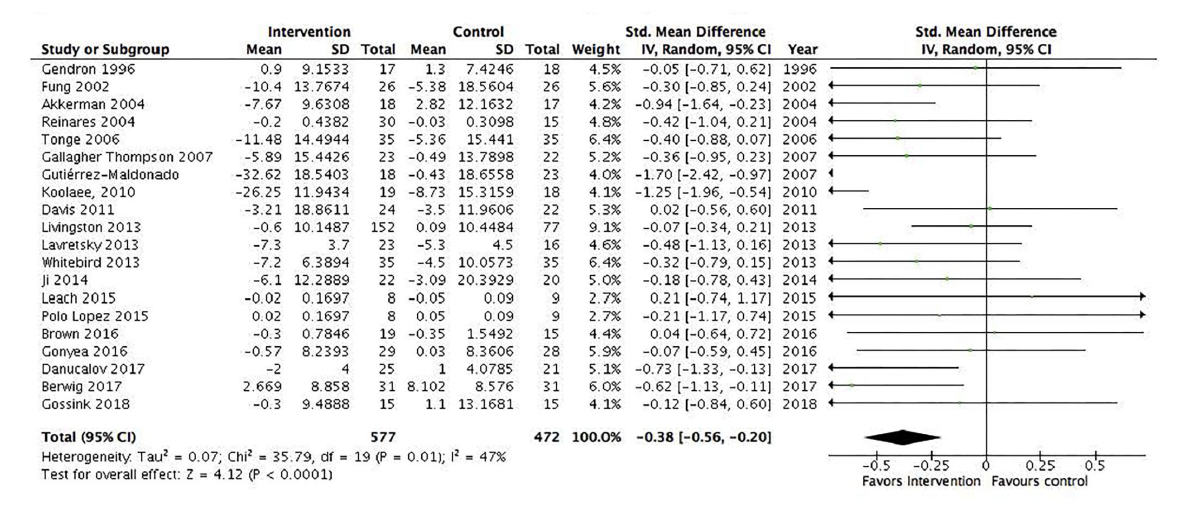
FIGURE8 Subgroup analysis of interventions that were manualized and ≥ 8 weeks duration, group/individual: All studies. Mean within-group changes and standardized mean differences.